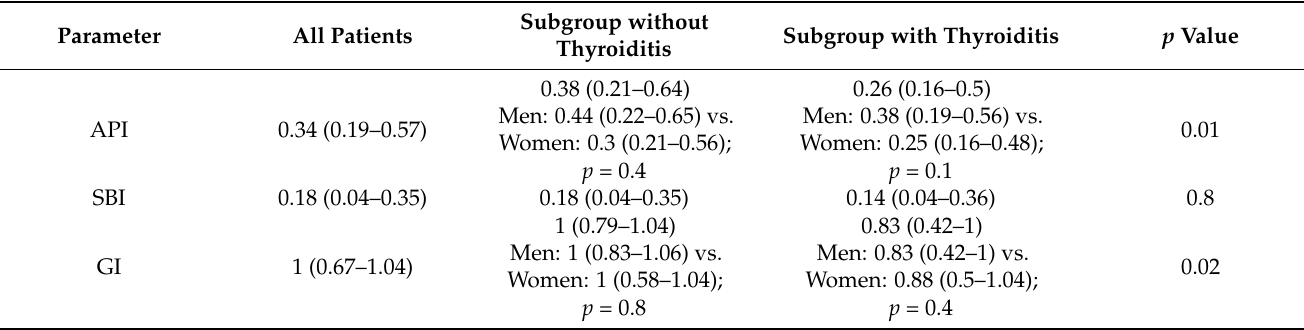
Table 2. The differences in gingival indices between analyzed subgroups. Median (IQR)]. Mann- Whitney U test.